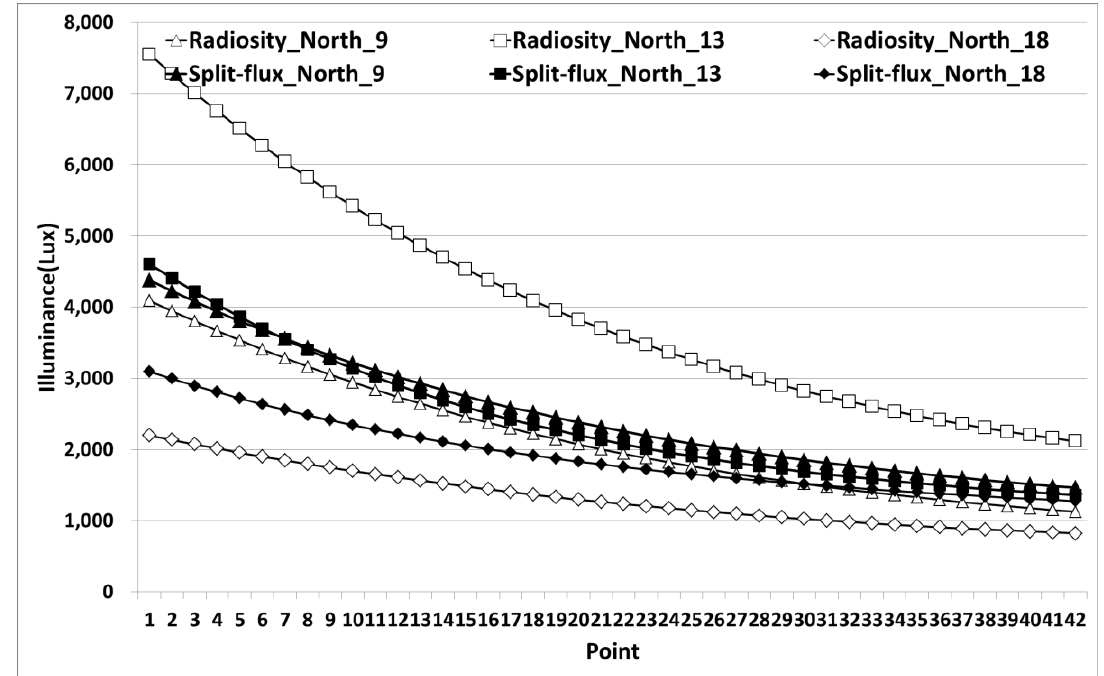
Figure 4. Interior illuminance at 42 reference points at 09:00, 13:00 and 18:00 for North orientation of